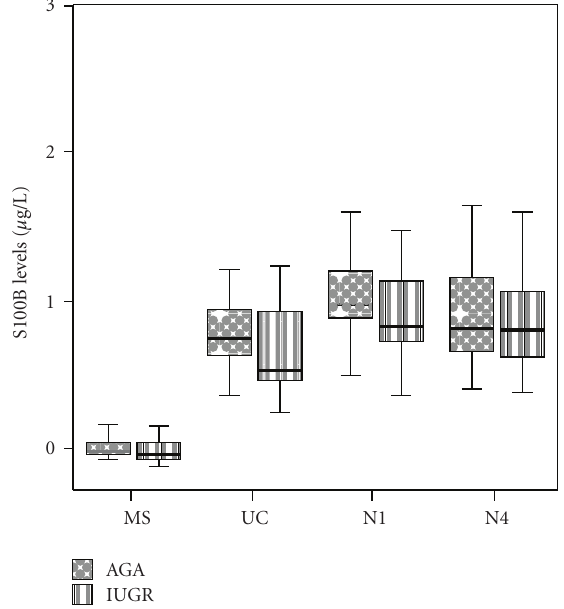
Figure 3: Box and whiskers plot presentation of maternal (MS), fetal (UC), neonatal day 1 (N1) and neonatal day 4 (N4) S100B levels. Each box represents the median concentration with the interquartile range. The upper and lower whiskers represent the